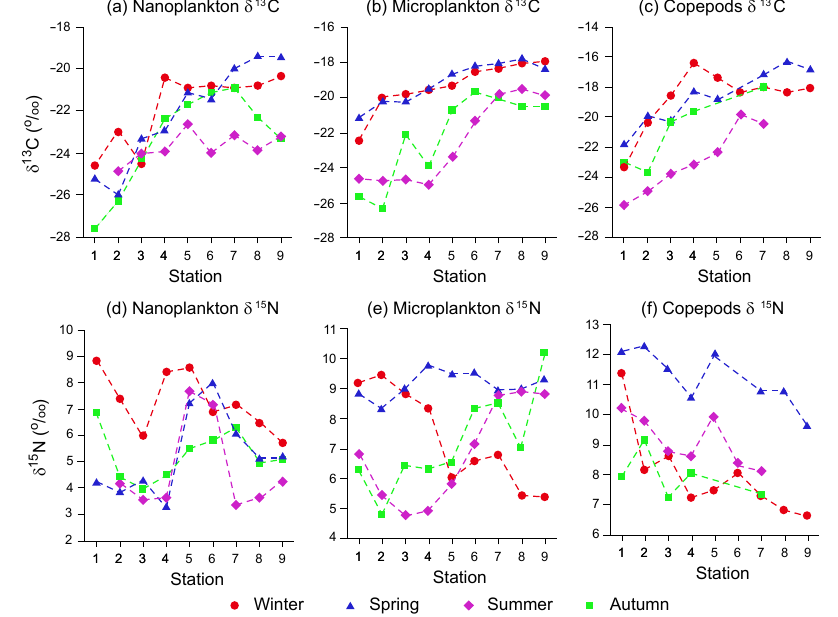
Figure 2. Temporal and spatial variations in plankton δ 13 C (‰) and δ 15 N (‰).